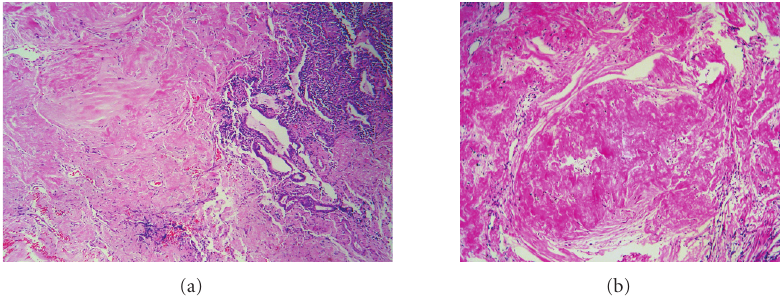
Figure 2: (a) Marked changes in lung architecture determinated by deposition of hyaline tissue masses accompanied by sparse lymphocytic infiltrate that compresses and distorts the remaining bronchioles (hematoxilin-eosin stain; original magnification, x40). A higher magnification (b) demonstrates that the mass is composed by hypocellular collagen lamellae (hematoxilin-eosin stain; original magnification,